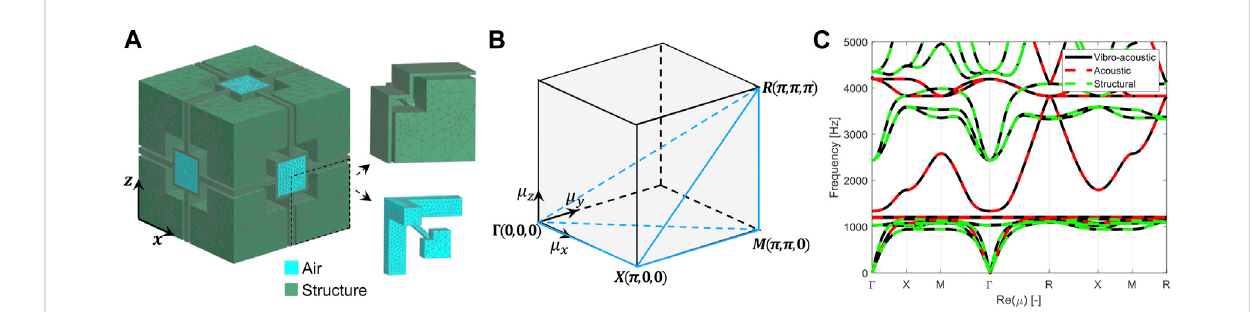
with an error of 6 · 10 – 3 or smaller. Note that the relative error TABLE 1 Overview of the results: DOFs after applying the Bloch- Floquet BCs, the total required time and the relative error when increases with increasing frequency due to the validity of the modal applying the BMS and GBMS technique to the vibro-acoustic 2D reduction basis. periodic case. To further accelerate the dispersion curve calculation, the FOM boundary DOFs are also reduced with the GBMS technique. n s , A = 100 and n a , A = 30 are chosen for the structural and acoustic parts, respectively. This results in a reduced system with 704 DOFs, or 390 DOFs after applying the Bloch-Floquet BCs. With this reduction, the total calculation time reduces further to 271 s,